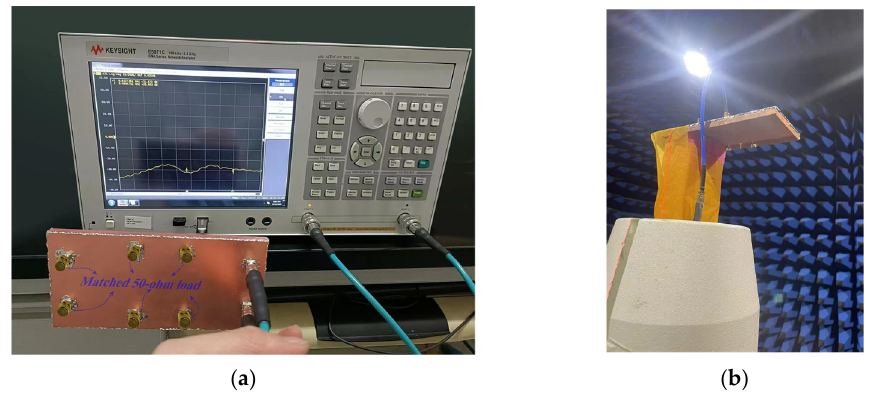
Figure 12. Photographs of the test site where the MIMO antenna was tested. ( a ): Vector network measurement analyzer and ( b ): SATIMO anechoic chamber.